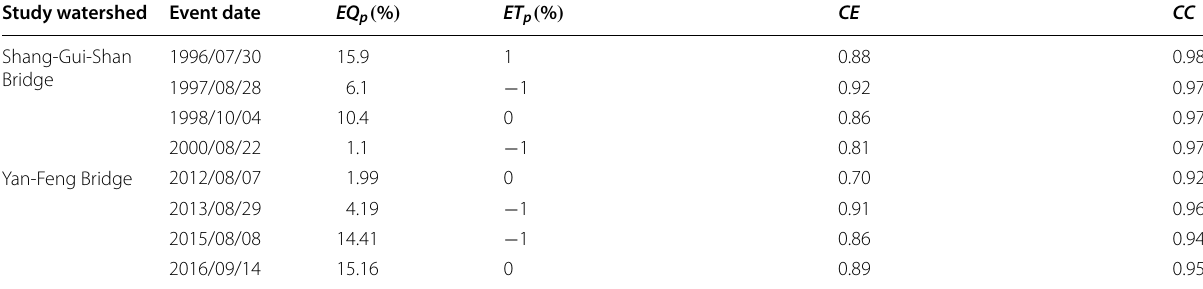
Table 3 Runoff simulation results derived in the both study watersheds Study watershed Event date EQ p ( % ) ET p ( % ) CE